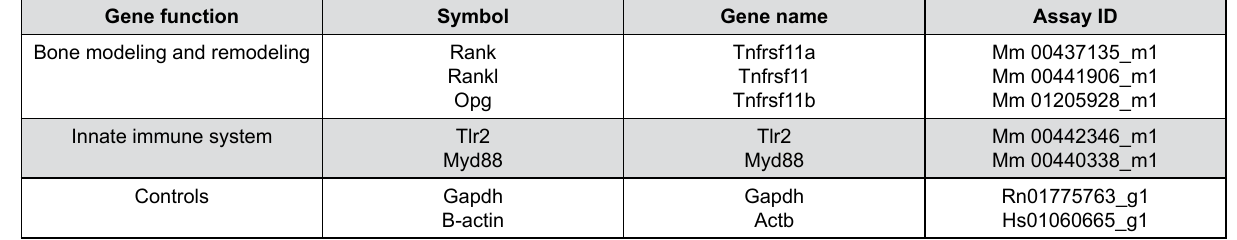
Figure 2- Description of studied genes